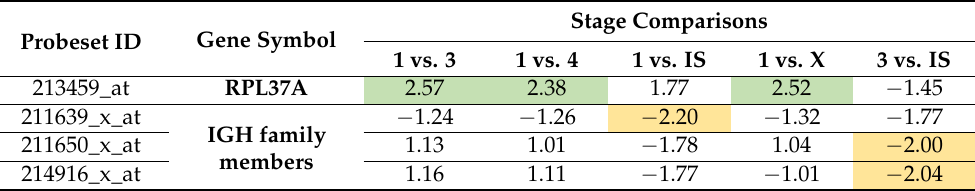
Table 6. Fold change in antigen transcript levels that achieved significance, when comparing T stage. Light green cells indicate values that are increased by greater than 2-fold, yellow cells indicate values that are decreased by greater than